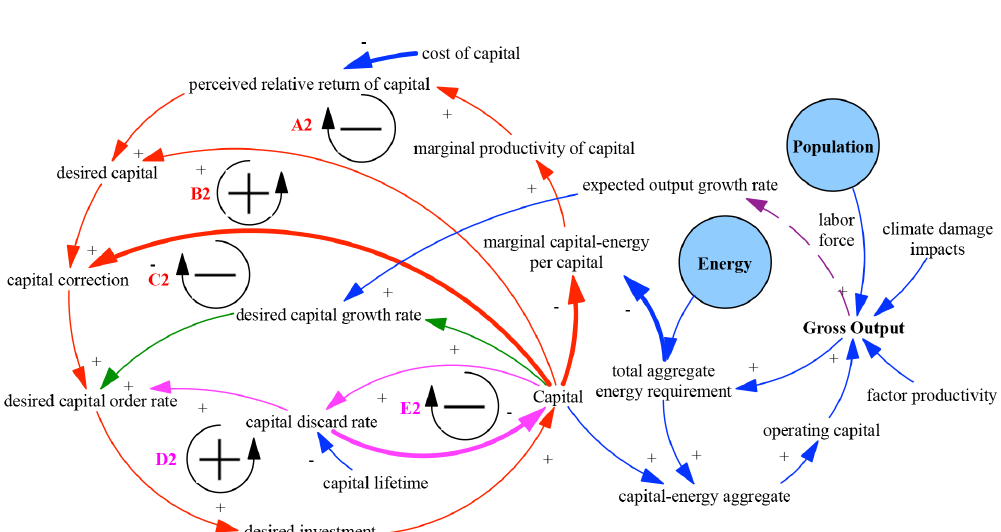
Figure 4. CLD in the economy